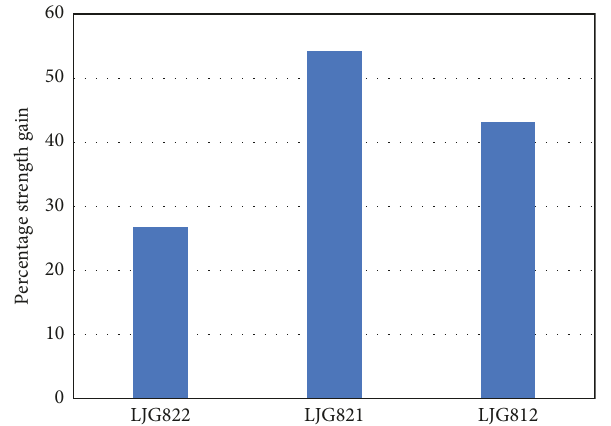
Figure 4: Percentage strength gain of LJG